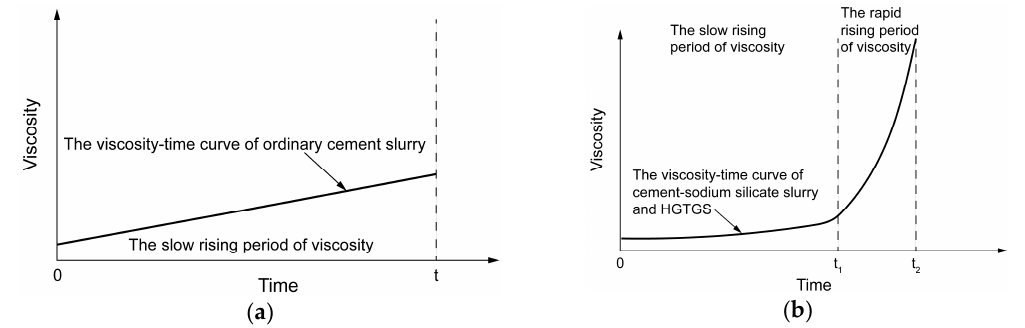
Figure 9. Schematic diagram of the division of viscosity periods of the ordinary cement slurry, the cement-sodium silicate slurry and the HGTGS at a specific temperature. ( a ) Schematic diagram of the division of viscosity periods of ordinary cement slurry; ( b ) schematic diagram of the division of viscosity periods of the cement-sodium silicate slurry and the HGTGS.